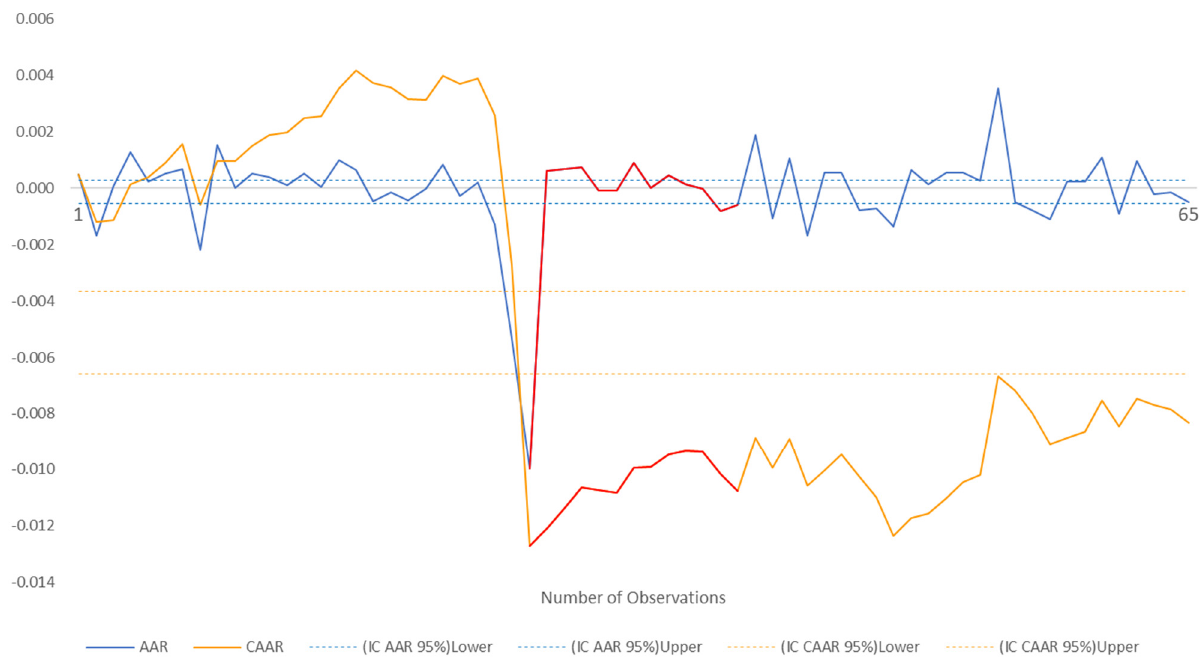
Figure 3. Aggregated abnormal returns (AAR) and cumulative aggregated abnormal returns (CAAR) over the event window for the sample covered. over the event window for the sample